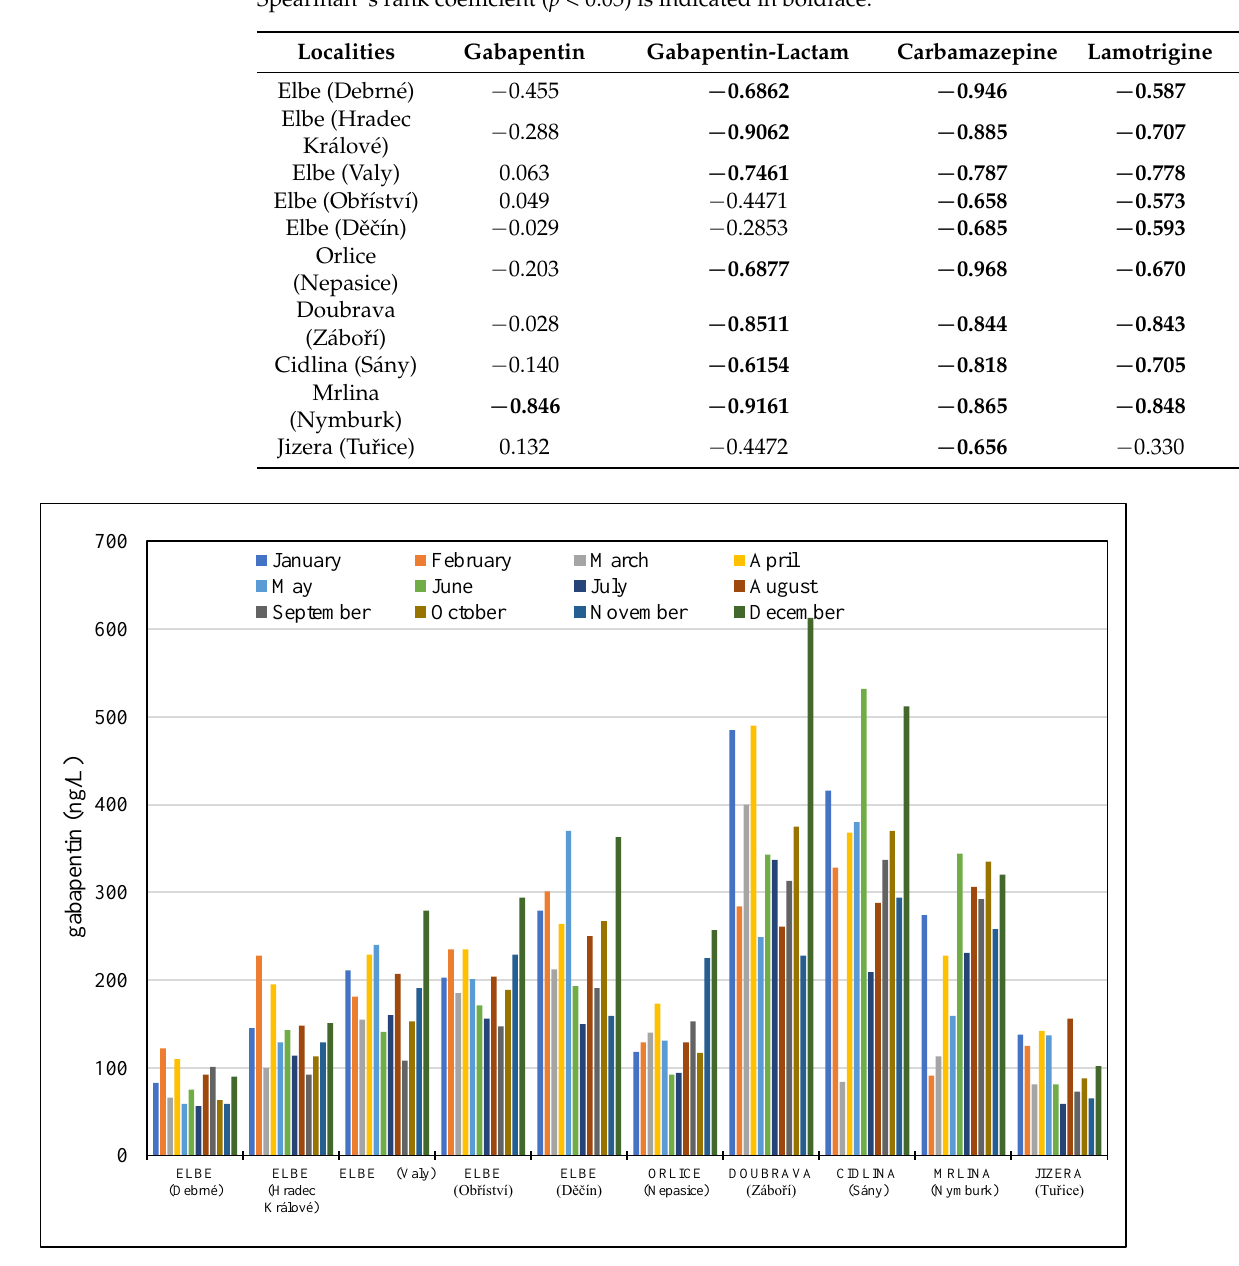
Figure 3. Residues of gabapentin in surface water of the Elbe River basin.